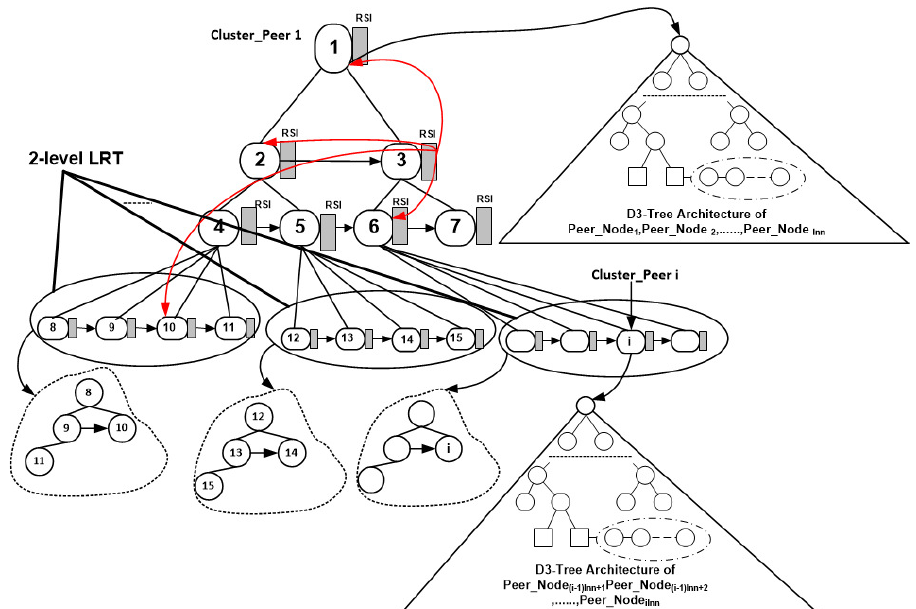
Figure 4. The ART + structure for b =